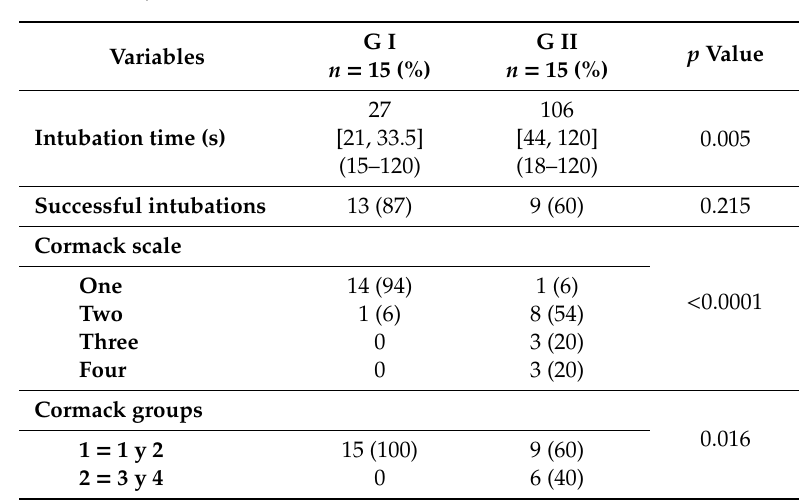
Table 1. In vitro test results obtained during mannequin intubation for first group (GI) (intubation with 213 proposed video laryngoscope (VDL) Hybrid 1. 0) and second group (GII) (intubation with a Macintosh No. 3